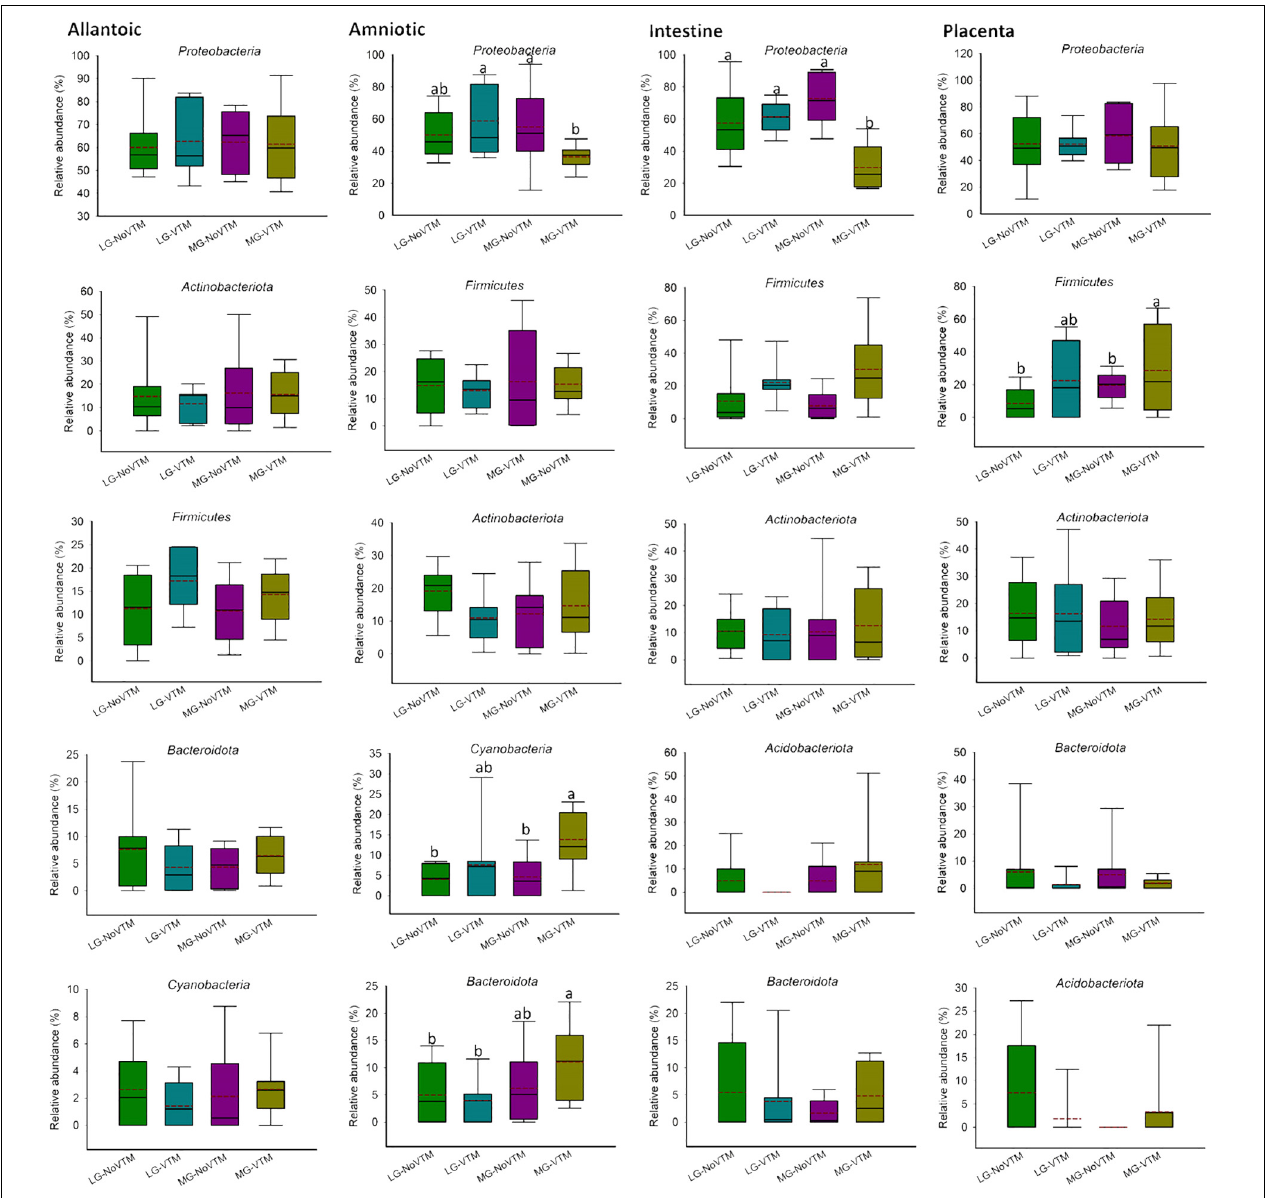
FIGURE 7 | The effects of rate of gain, and vitamin and mineral supplementation on the relative abundance of the five most relatively abundant phyla present in allantoic and amniotic fluid, and intestine and placental microbiota in 83-day-old calf fetuses. The different lowercase letters indicate significantly different means ( P <